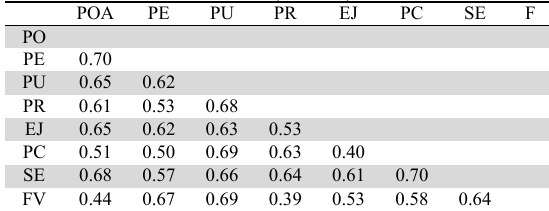
Fornell-Larcker